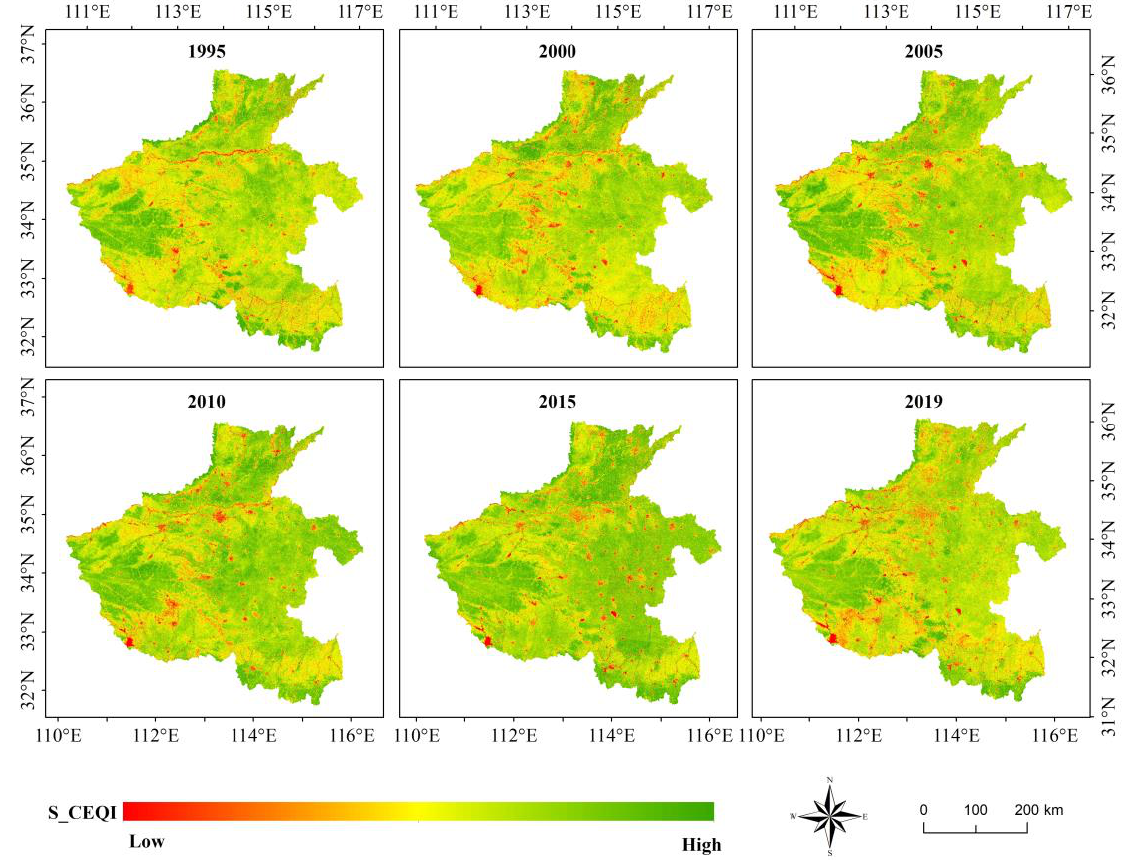
Figure 7. Ecological environmental quality index of the Henan Province using S_CEQI model .